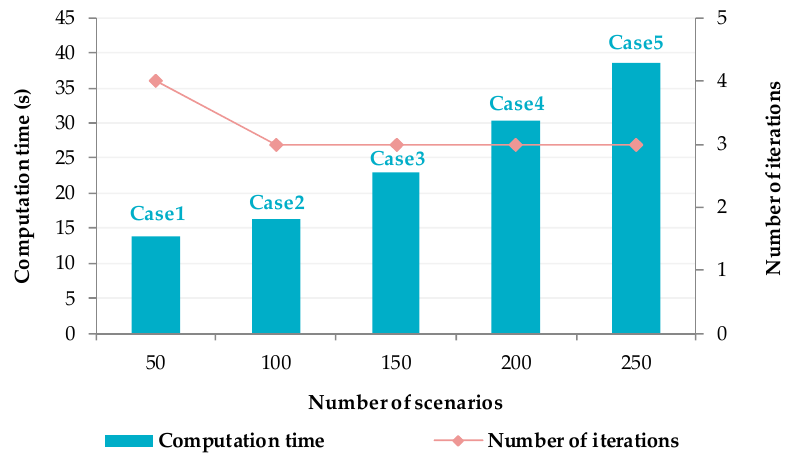
Figure 7. Computation time and the number of iterations required for different scenario sets with varying numbers of scenarios.